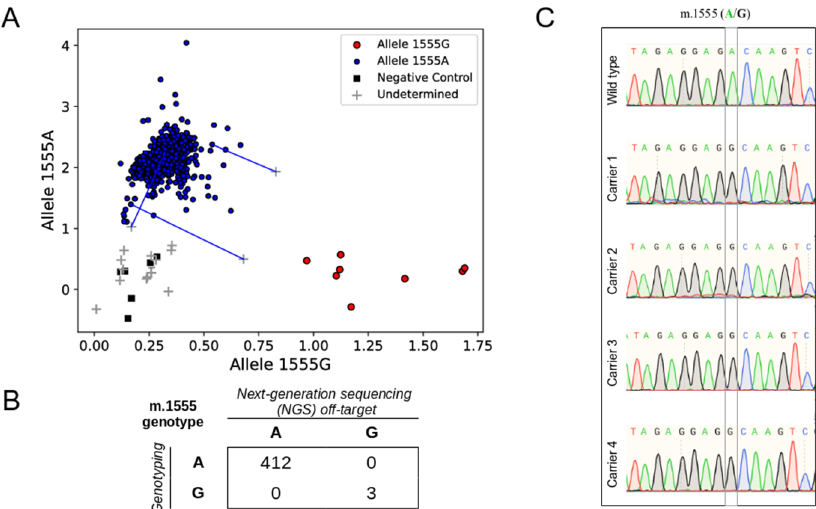
Figure 3. Validation of MT-RNR1 m.1555A > G genotypes identified by o ff -target reads. ( A ) Genotype clusters generated by a fluorescence (FRET)-based assay. Wild-type samples are colored in blue, samples carrying m.1555G are colored in red, non-template controls are shown as black squares, and uninformative samples are shown with a gray cross. Samples were genotyped in duplicates. Blue lines connect uninformative outliers with their wild-type duplicates. ( B ) Distribution of the MT-RNR1 m.1555A > G genotypes obtained with next-generation sequencing (NGS) o ff -target and fluorescence-based genotyping. ( C ) Sanger sequencing chromatograms corresponding to a wild-type sample control (Wild type) and the four m.1555G carriers identified among the research